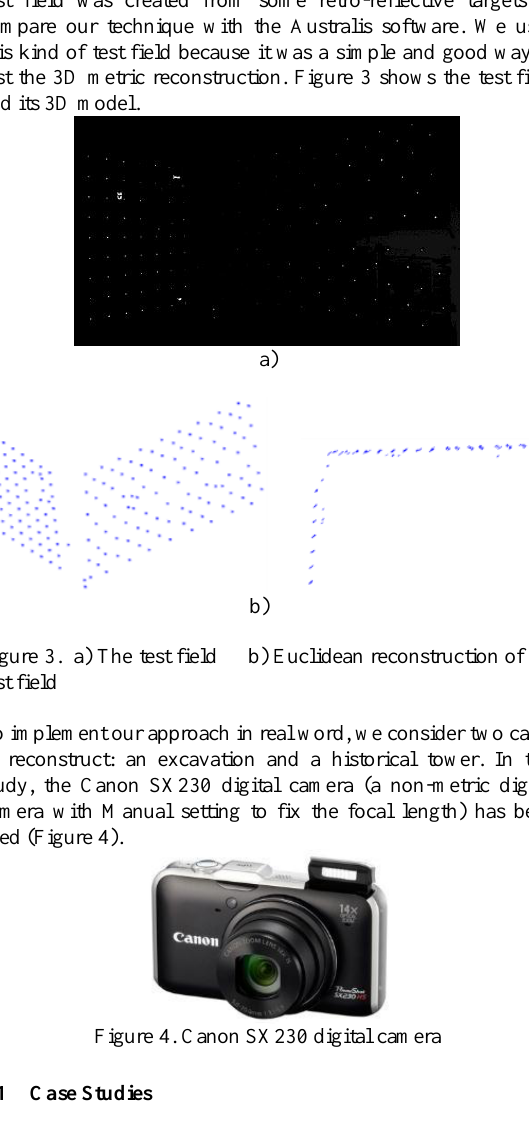
Figure 2. Upgrade from projective to Euclidean reconstruction